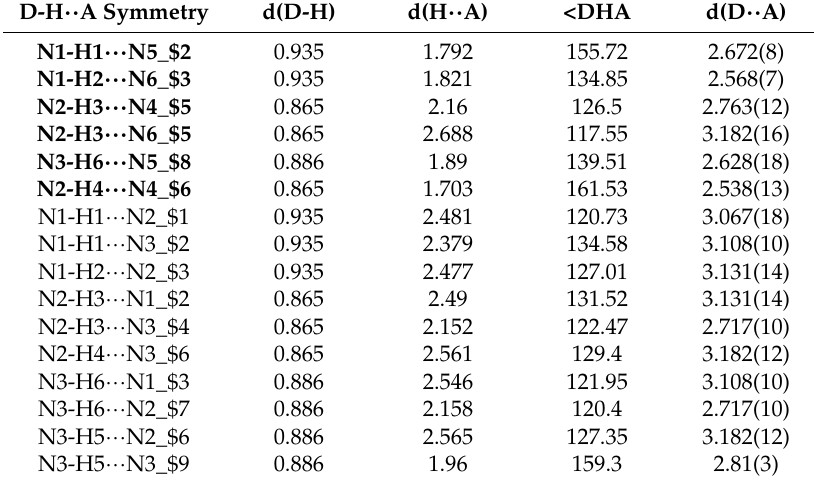
Table A4. Hydrogen bond D-H ·· A lengths and angles at 36.21(5) GPa (2015_10). Hydrogen bonds linking to neighboring triazine ring nitrogen atoms are displayed in